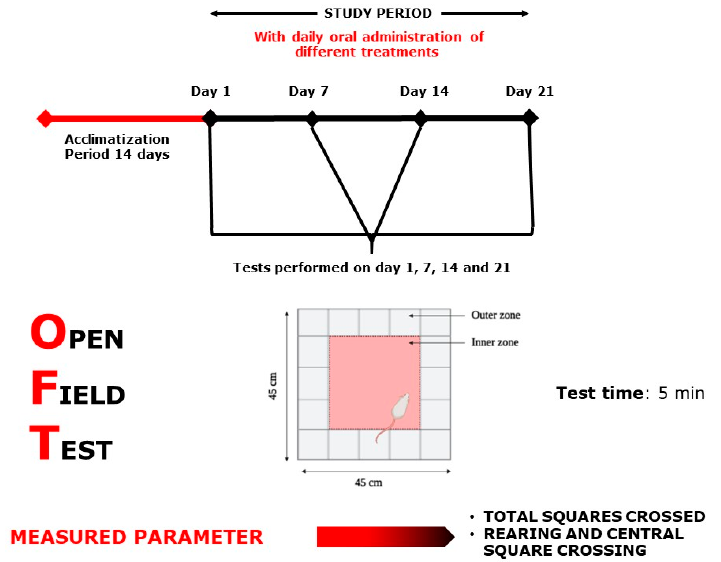
Figure 11. Open Field Test scheme.